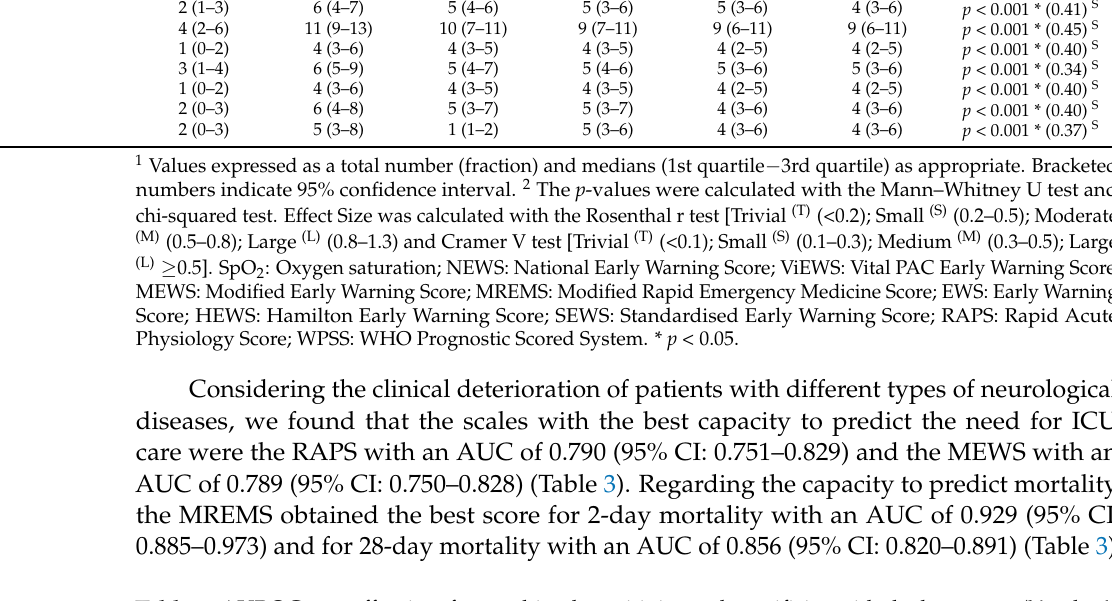
Table 3. AUROC, cut-off points for combined sensitivity and specificity with the best score (Youden’s test) for the different scales analyzed (for intensive care unit, 2-, and 28-day